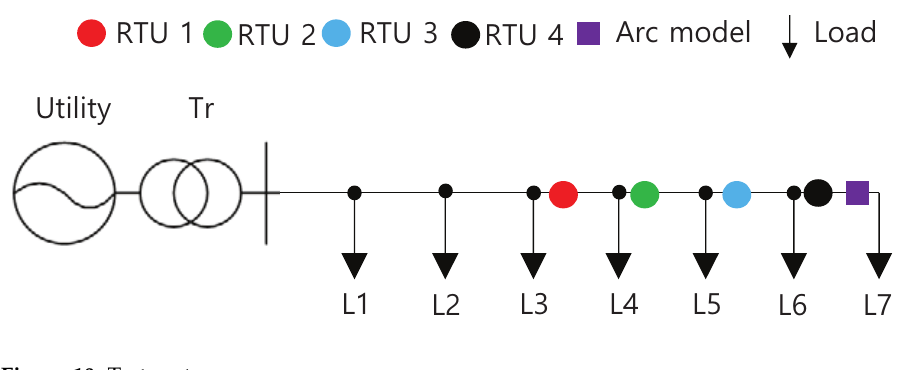
Figure 10. Test system.